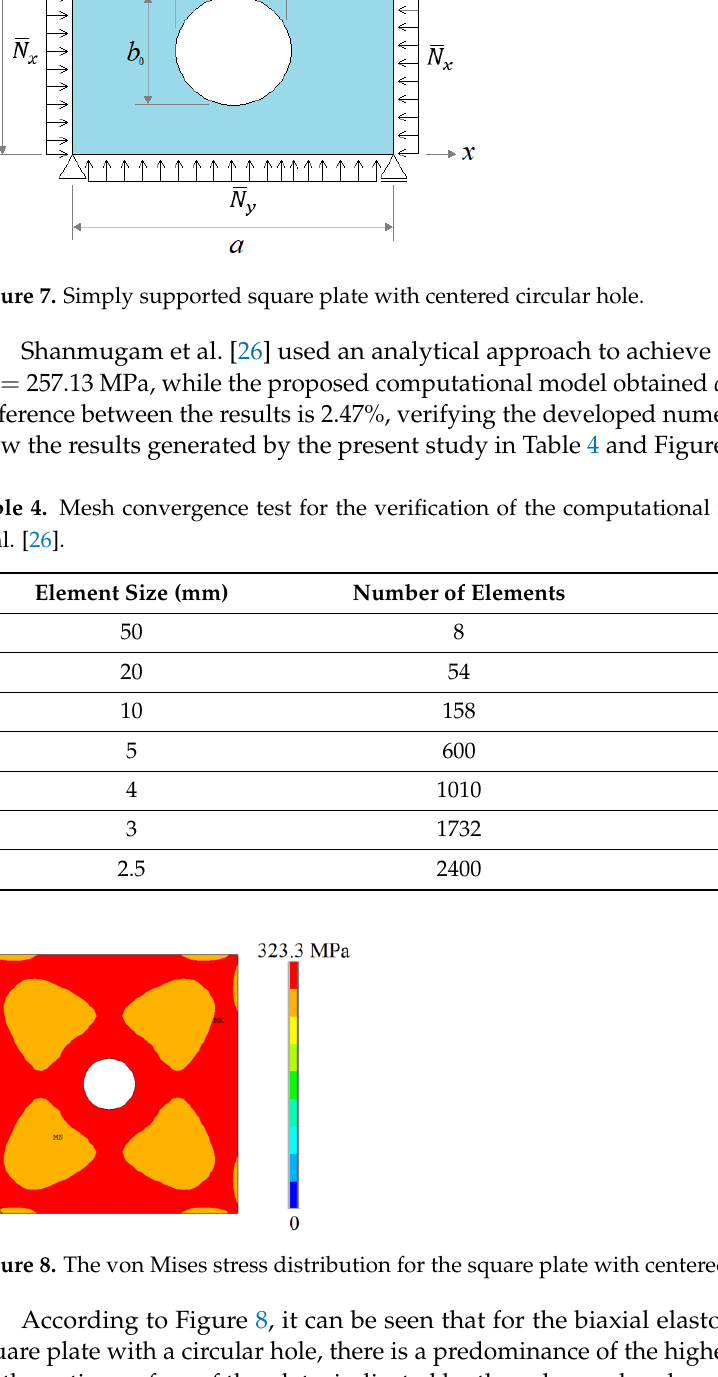
Figure 9. Simply supported stiffened plate with semi-circular opening (Adapted from [27]). To numerically simulate the plate of Figure 9 a mesh convergence test was performed (Table 5) taking into account the width of 170 mm, defining a finite element size of 20 mm. From this, both for the width of 170 mm and for the widths of 340 mm and 510 mm, this same spatial discretization was adopted. It is important to highlight that the last column of Table 5 presents the ratio between the ultimate buckling load when the lateral load is applied ( 𝑁̅ uQ ) and the ultimate buckling load when the lateral load is null ( 𝑁̅ 𝑢0 ), as in Ku- mar et al. [27].